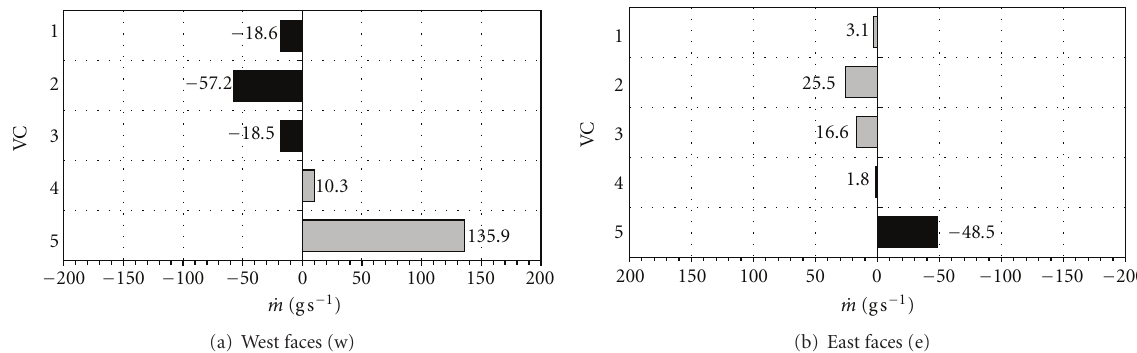
Figure 11: Mass flow rate predictions across East (exterior border) and West (interior border) of air curtain control volumes, per unit length.